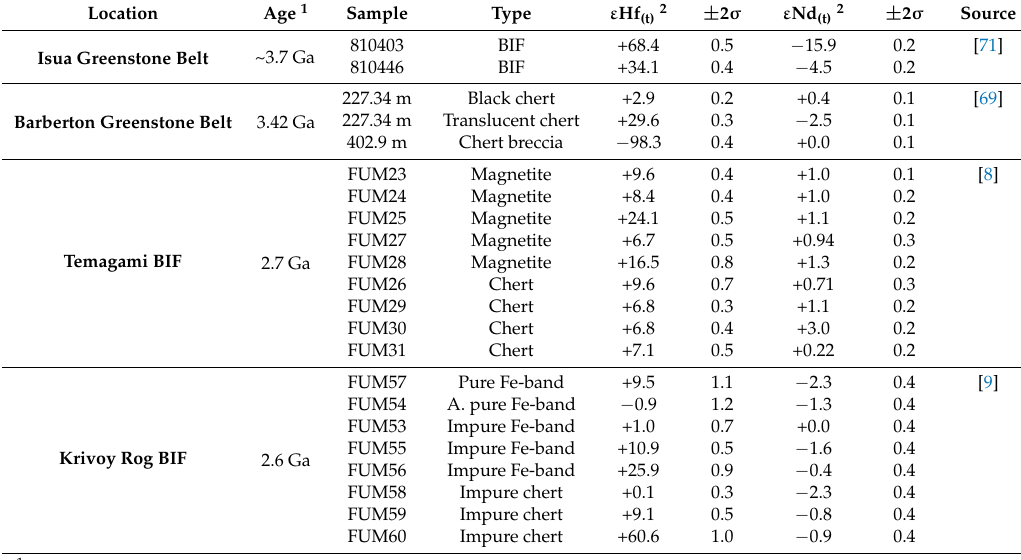
Table 1. Published ε Nd (t) and ε Hf (t) values (epsilon notation: measured isotope ratios relative to a reference material and multiplied by 10,000 at a certain time) of Archean Banded Iron Formations (BIFs).